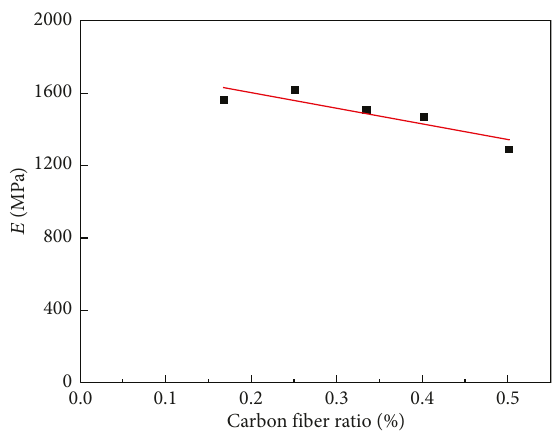
Figure 8: Elastic modulus of specimens with different carbon fiber ratios.